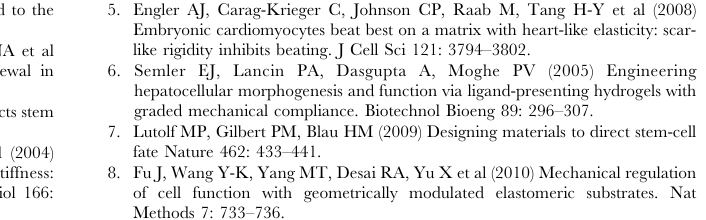
(Vollath F4 algorithm) set at a 400 nm step stage positioning. For measurements of gel thickness, the system was used to measure the relative z-positions of 1 m m fluorescent YG carboxylate micro- spheres (Polysciences) bound to glass surface of a 96 well glass- bottom plate and on the surface of PA gels representing each stiffness condition.